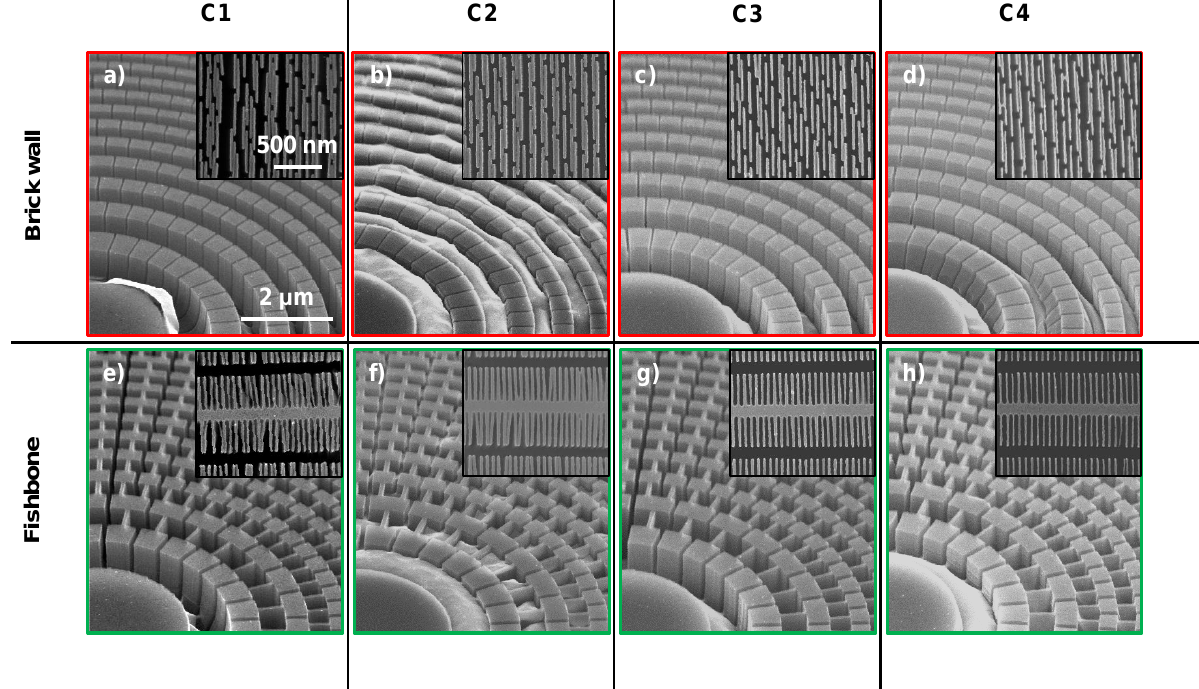
Figure 4. Brick wall (red frame) and fishbone (green frame) zone plate designs etched for 6 min at MACE conditions ( a ) C1, ( b ) C2, ( c ) C3 and ( d ) C4 and ( e ) C1, ( f ) C2, ( g ) C3 and ( h ) C4, respectively. The two designs shown per MACE condition were processed on the same Si chip. Same scale bars apply to main SEM micrographs and the insets. The insets show the outermost